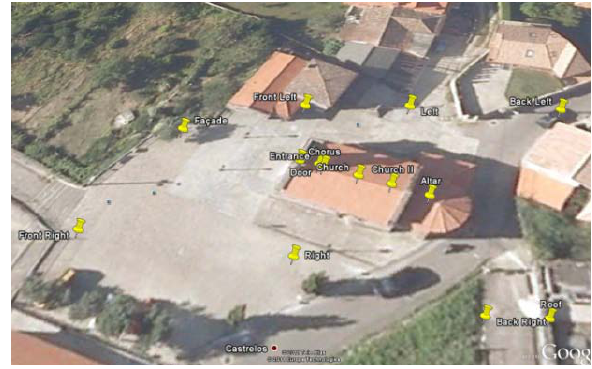
Figure 2 Different scan positions